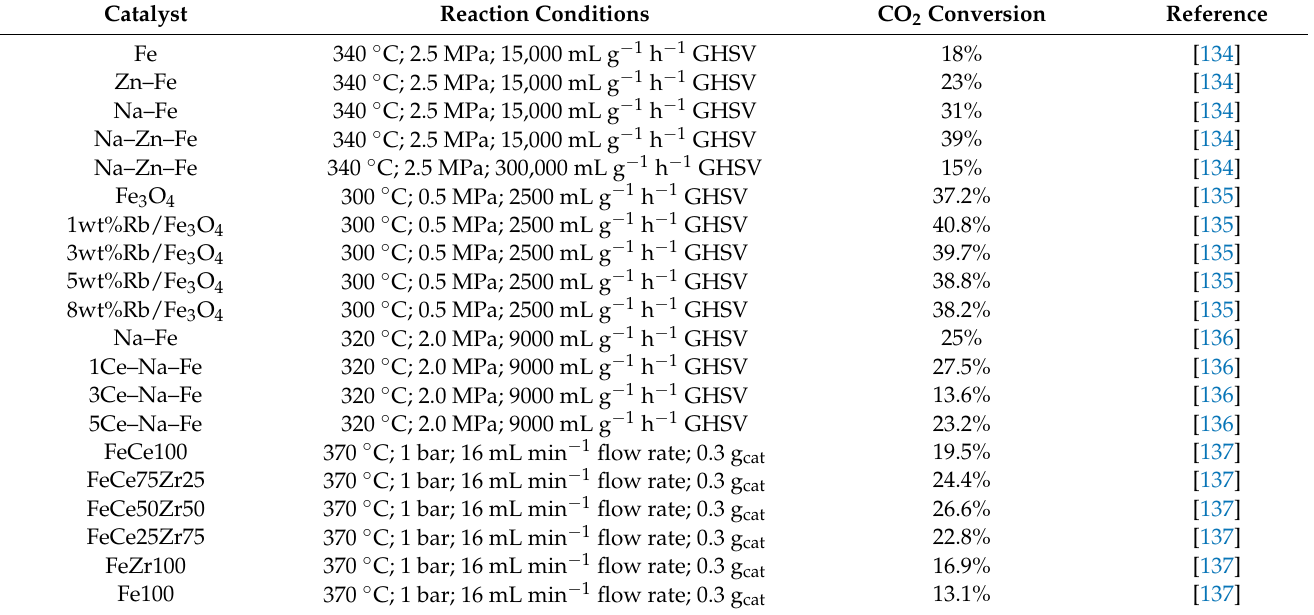
Table 6. Innovative catalysts for hydrocarbon production from CO 2 through RWGS route, tested at CO 2 /H 2 feed ratio of